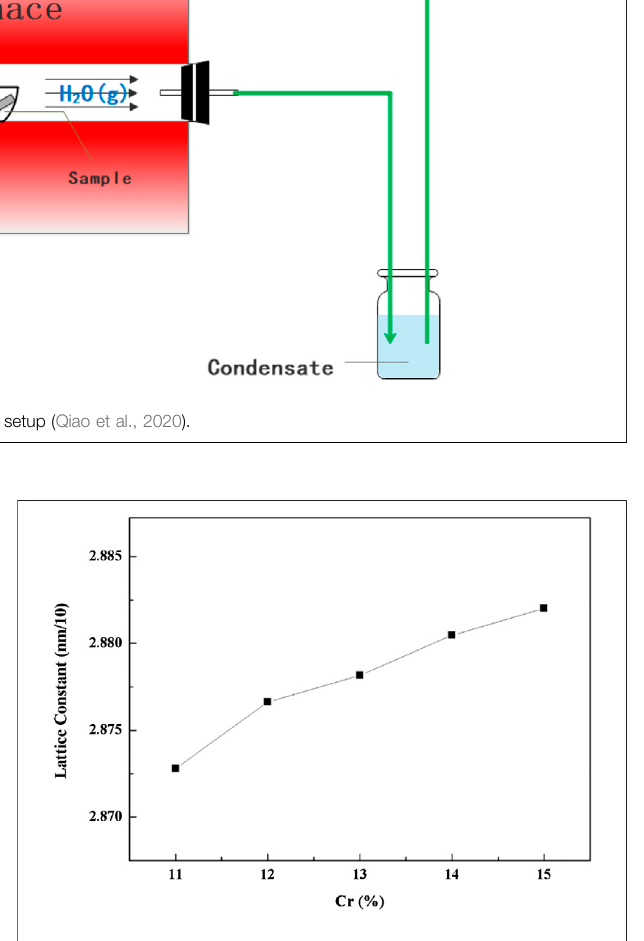
FIGURE 3 | Average composition-lattice constant curve of Fe – x Cr – 6Al alloy in room